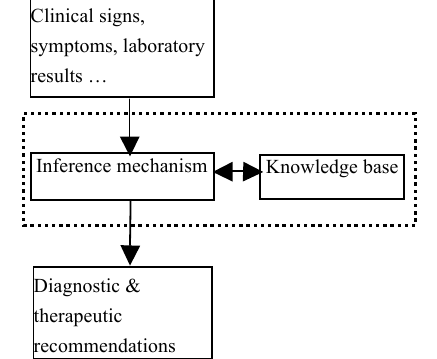
Figure 2.1: The General Model of